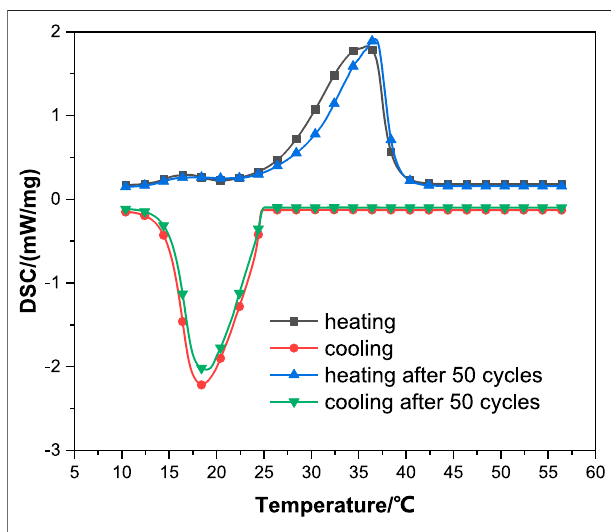
FIGURE 1 | DSC curve of paraf fi n wax after 0 and 50 cycles.